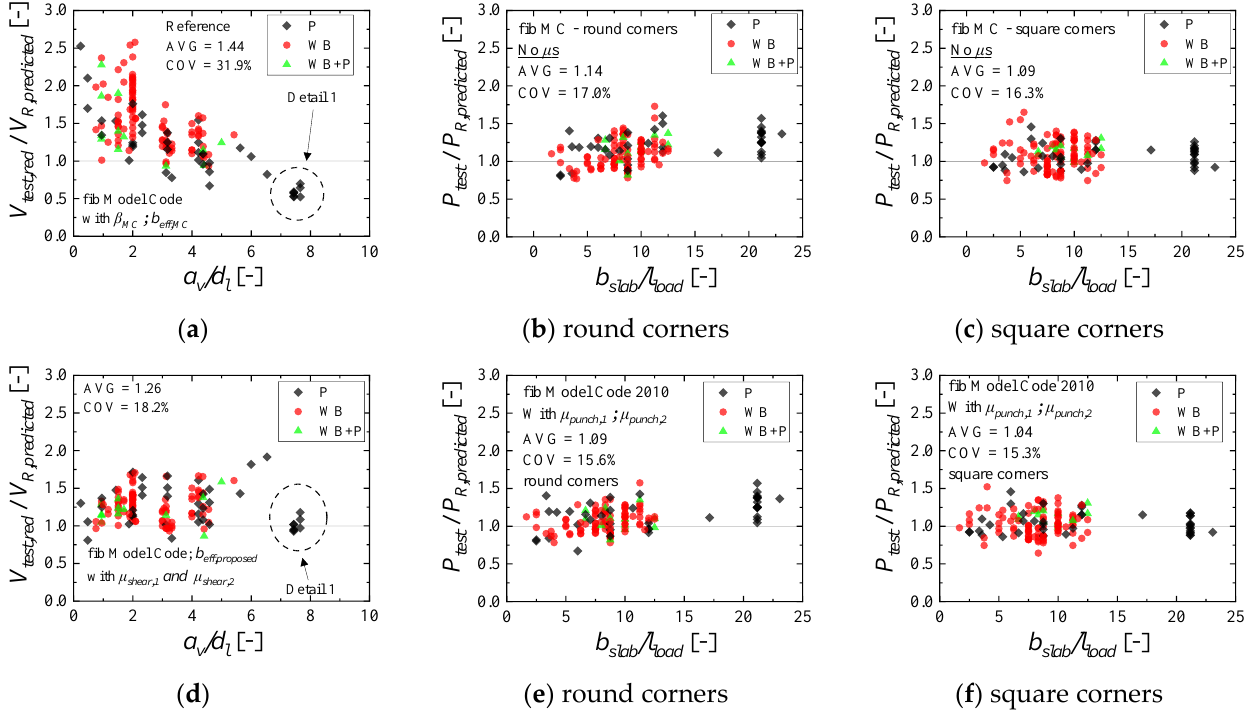
Figure 18. Comparison between tested and predicted resistances the fib Model Code 2010 expressions for: ( a ) one-way shear and without the correction factors µ ; ( b ) punching shear, without the correction factors µ , and using round corners for the control perimeter; ( c ) punching shear, without the correction factors µ , and using square corners for the control perimeter; ( d ) one-way shear, with the correction factors µ ; ( e ) punching shear expressions, with the correction factors, and using round corners for the control perimeter; ( f ) punching shear expressions, with the correction factors, and using square corners for the control perimeter. Note: P = punching failure; WB = wide-beam shear failure in one-way shear; WB + P = mixed mode between one-way shear and punching.